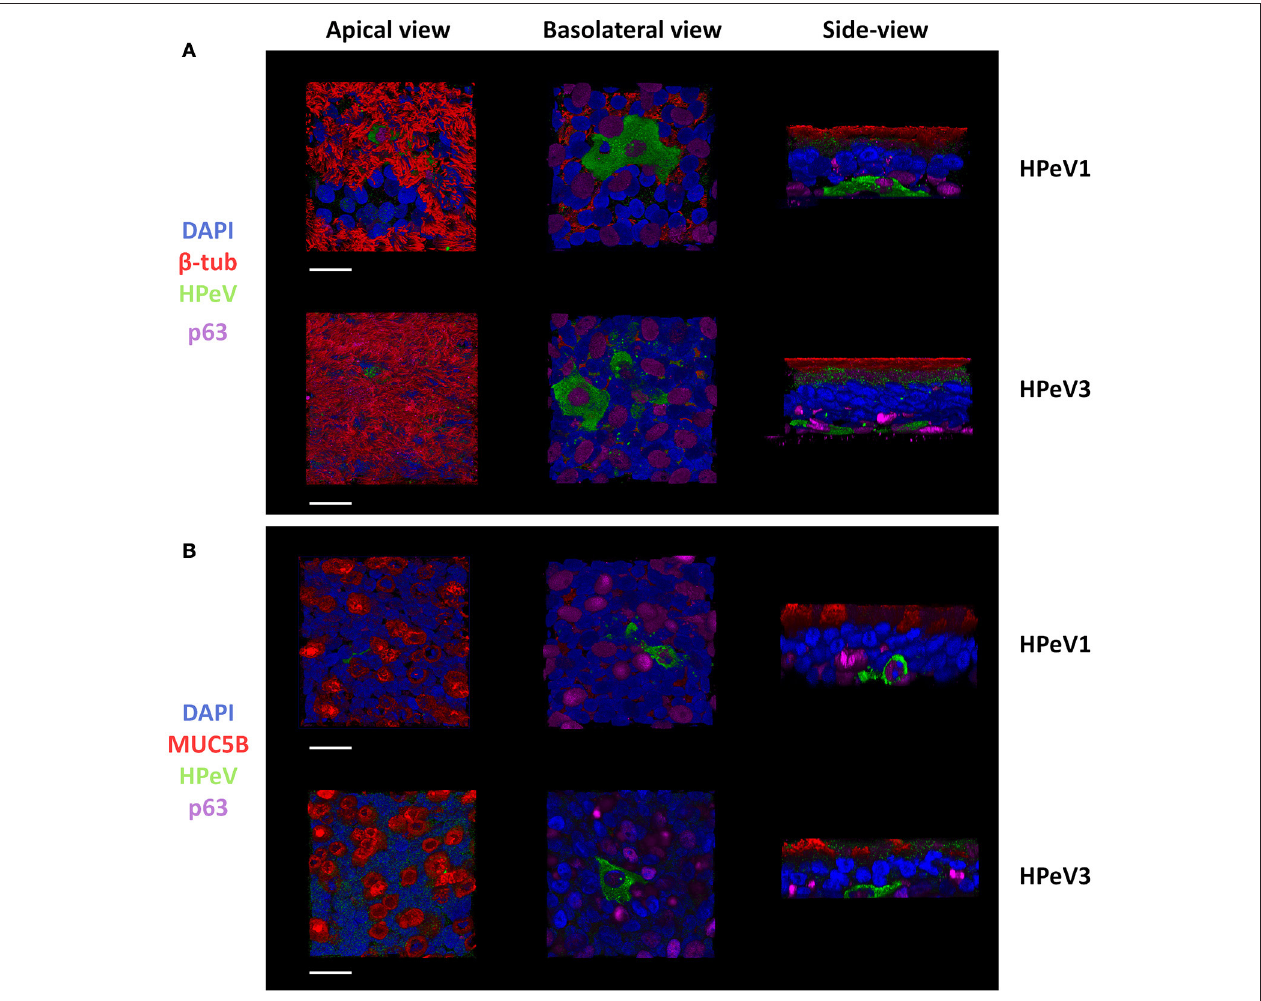
FIGURE 2 | Human parechoviruses target p63 positive basal cells in the airway epithelium. Confocal image stacks of HPeV1- and HPeV3-infected HAE cultures triple-stained by (A) ciliated cell marker β -tubulin (red), basal cell marker p63 (purple) and HPeV antibody (green) or (B) secretory cell marker mucin 5B (red), basal cell marker p63 (purple) and HPeV antibody (green). Nuclei stained by DAPI (blue). Scale bars, 20 µ